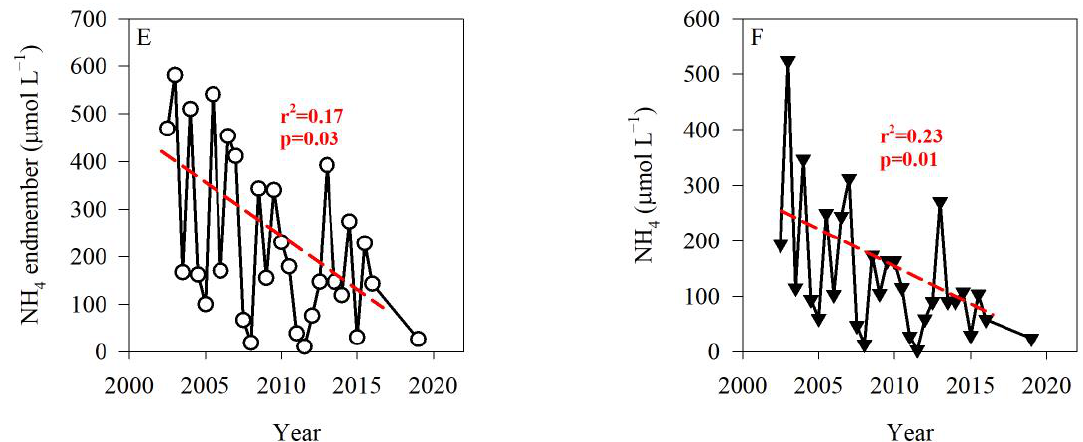
Figure 4. Time series of the calculated anthropogenic freshwater nutrient endmembers using equation 3 ( A , C , E, circles) and the time series of the measured nutrient concentrations at the surface water of the Histadrut station ( B , D , F, triangles). Data are shown for PO 43 − ( A , B ), NO 2 − + NO 3 − ( C , D ),